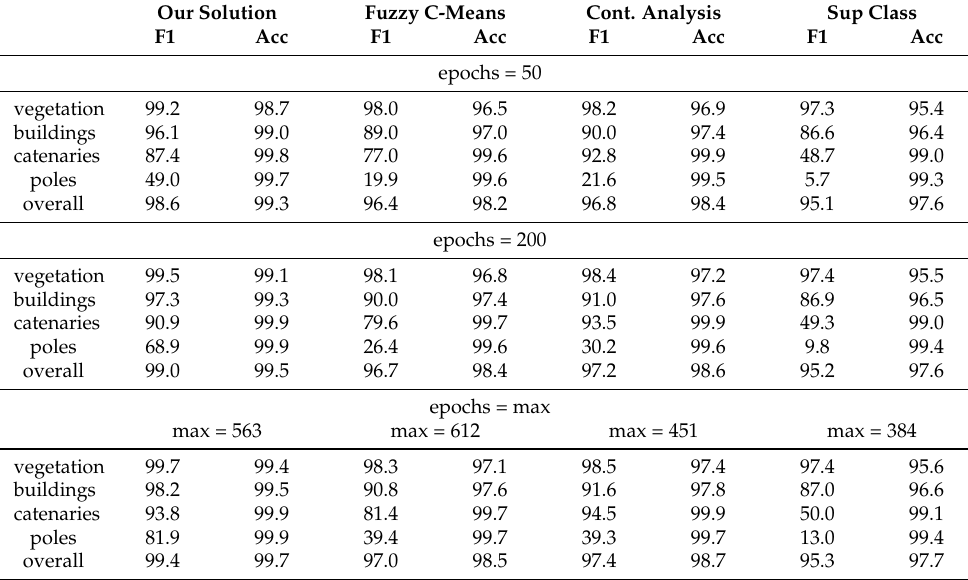
Table 8. F1 and accuracy for different numbers of